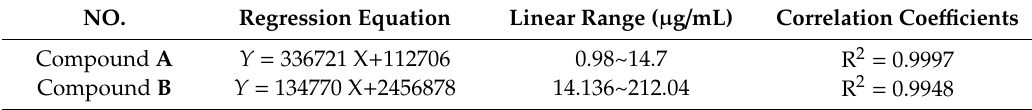
Table 3. Regression equations, linear ranges, and correlation coe ffi cients.